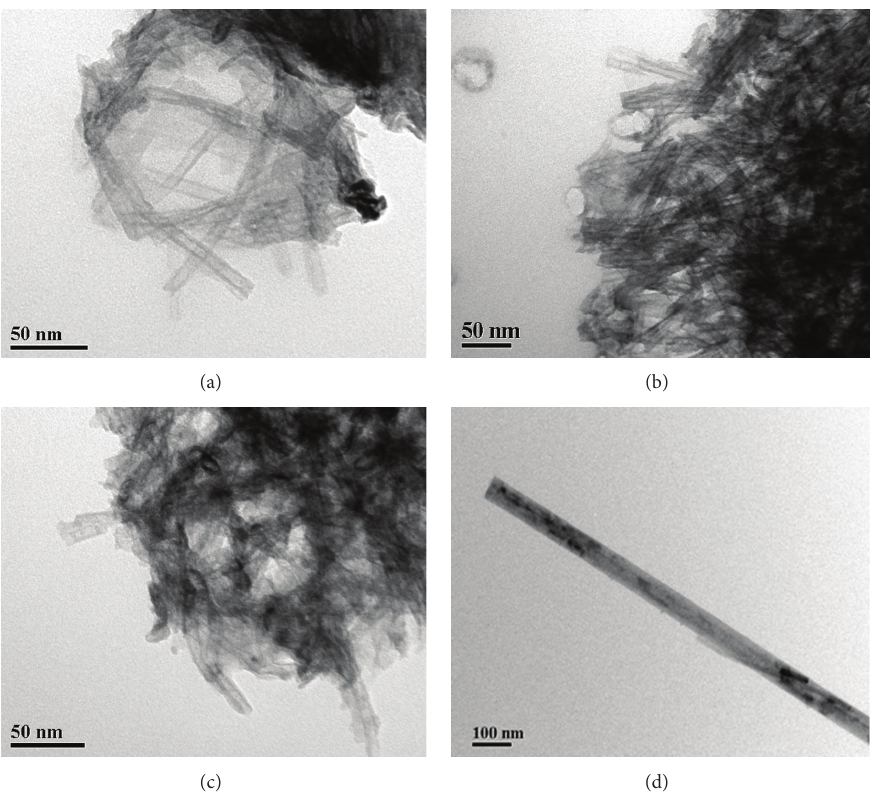
Figure 6: TEM images of the samples prepared at different reaction temperatures: (a) 110 ∘ C, (b) 130 ∘ C, (c) 150 ∘ C, and (d) 180 ∘